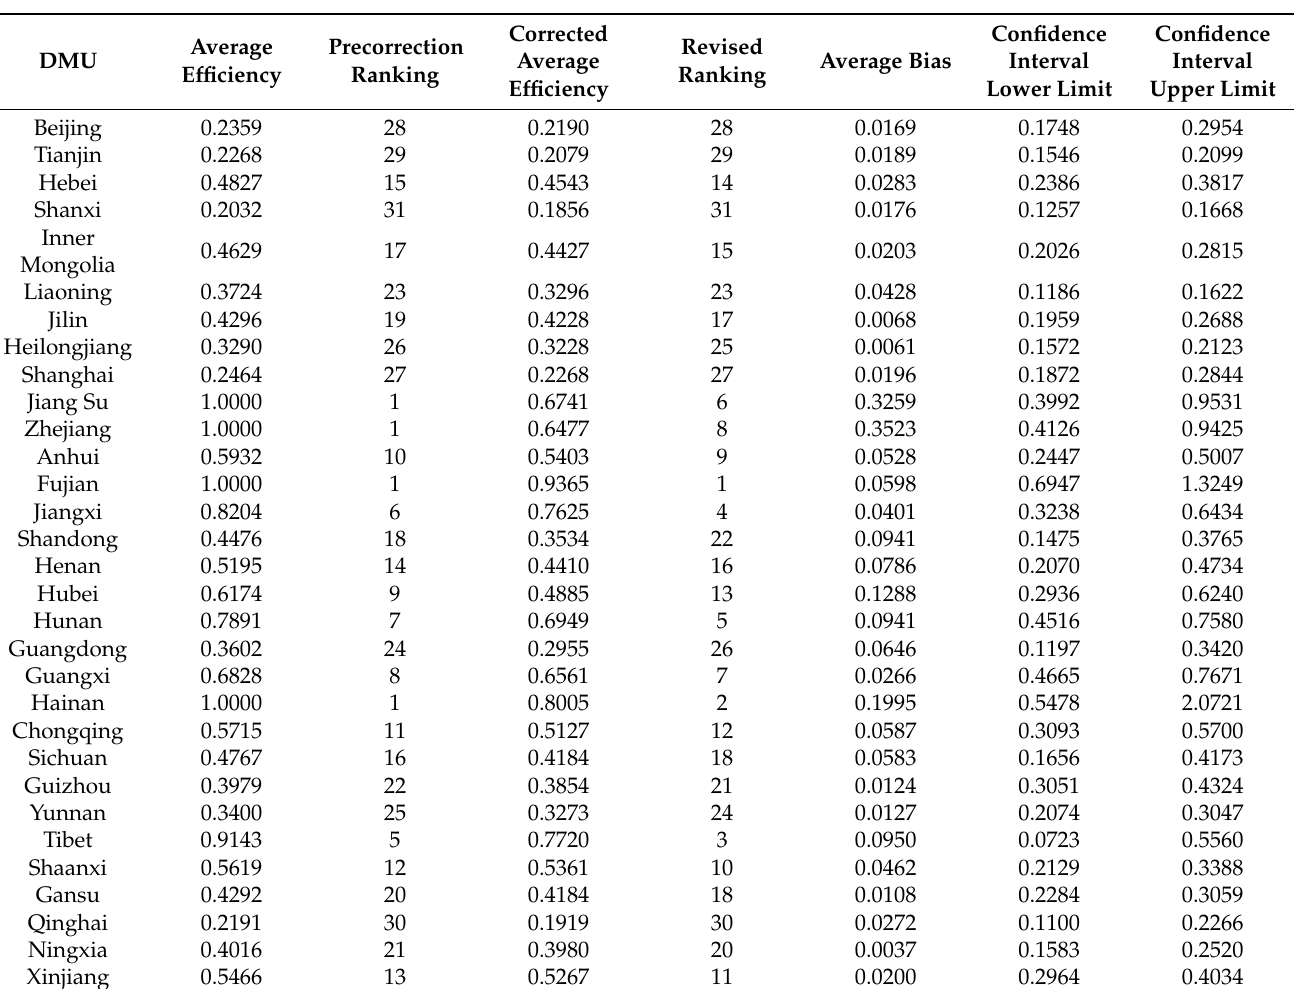
Table 3. Comparison results of the two